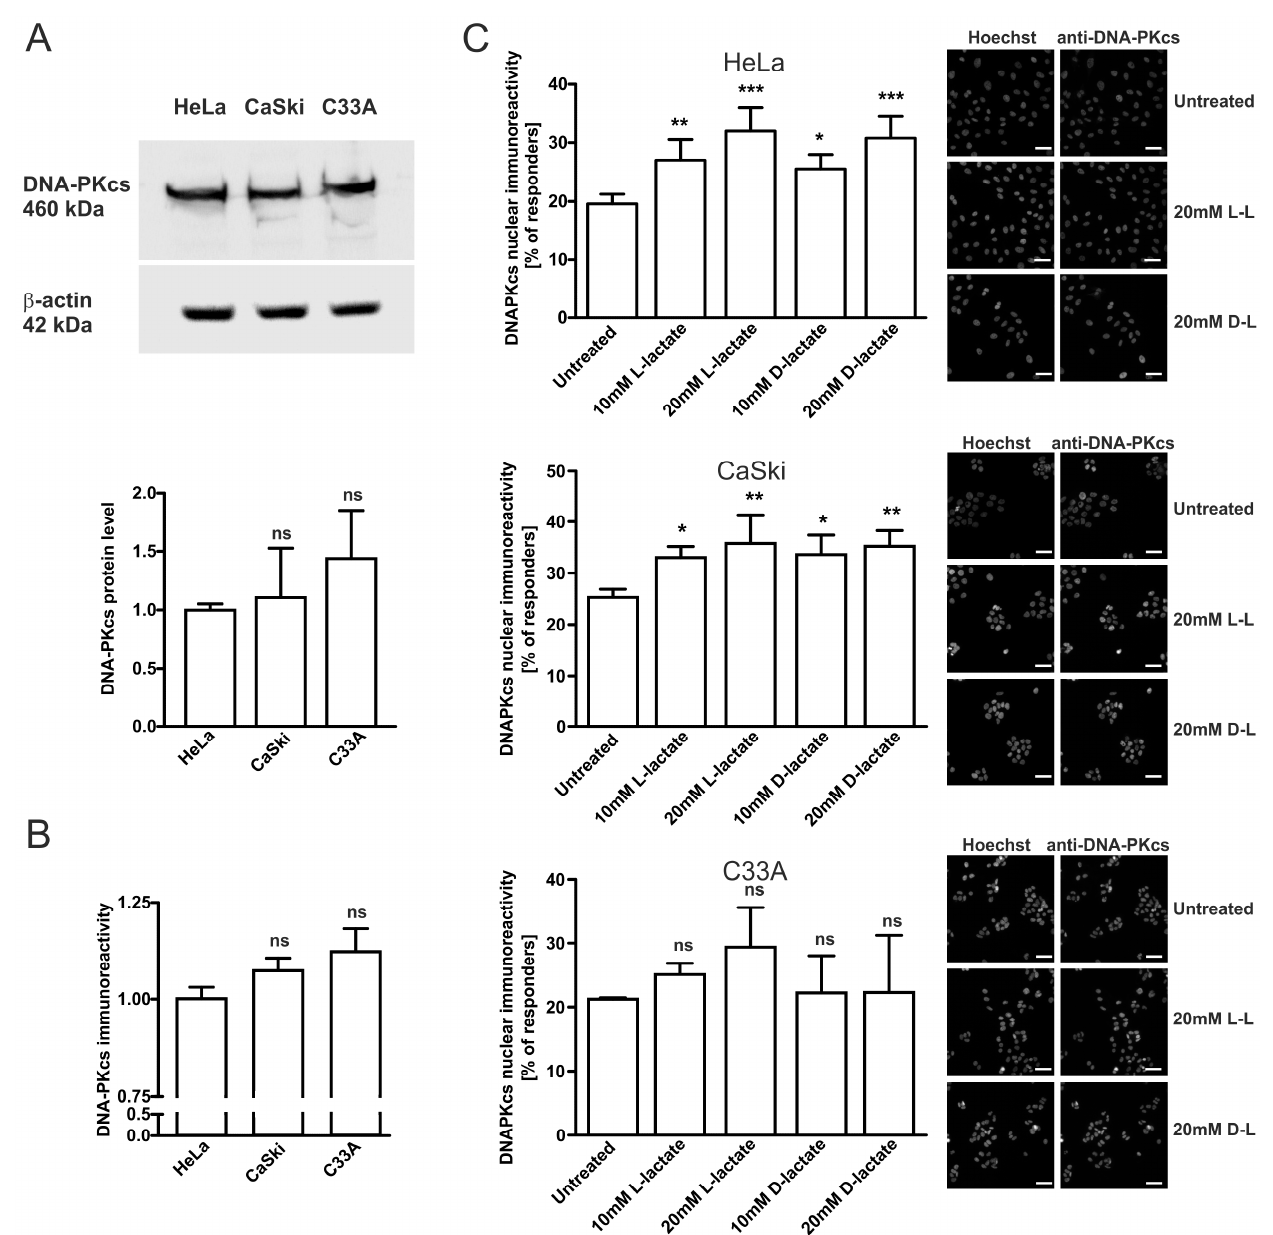
Figure 1. Lactate enhances nuclear localization of DNA-PKcs in cervical cancer cell lines. ( A ) The DNA-PKcs protein level in cell extracts was quantified using densitometry and presented as relative means ± SD of DNA-PKcs/ β -actin ratio normalized to HeLa cells (n = 4). ( B ) Immunocytochemical staining of DNA-PKcs, results are presented as relative means ± SD normalized to HeLa cells (n = 4), calculated from four independent experiments. ( C ) Cervical cancer cells were treated with increasing concentrations of L-lactate (L-L) and D-lactate (D-L) for 24 h before measuring cellular DNA-PKcs immunoreactivity. The graphs display the percentage of high DNA-PKcs immunoreactive cells (responders) of HeLa, CaSki, and C33A cells whose fluorescence overcame the threshold of mean fluorescence set on untreated corresponding cells. Data are presented as mean ± SD. Statistical significance was evaluated using one-way ANOVA followed by Tukey’s test. * p < 0.05, ** p < 0.01 and *** p < 0.001 indicate significant; not significant, ns. The scale bar is 50 µm.